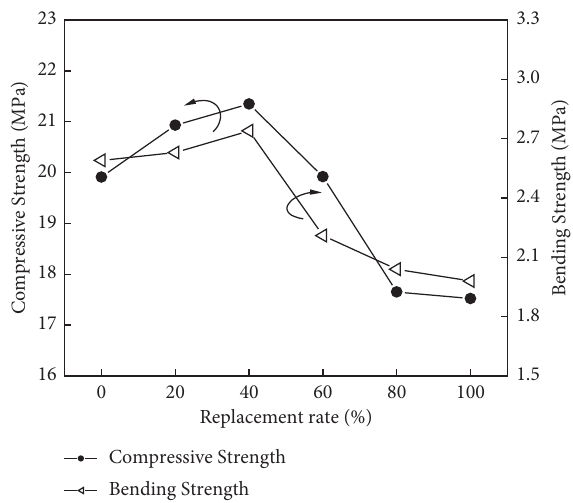
Figure 3: Relationships between compressive strength, bending strength, and replacement rate of RCCA.